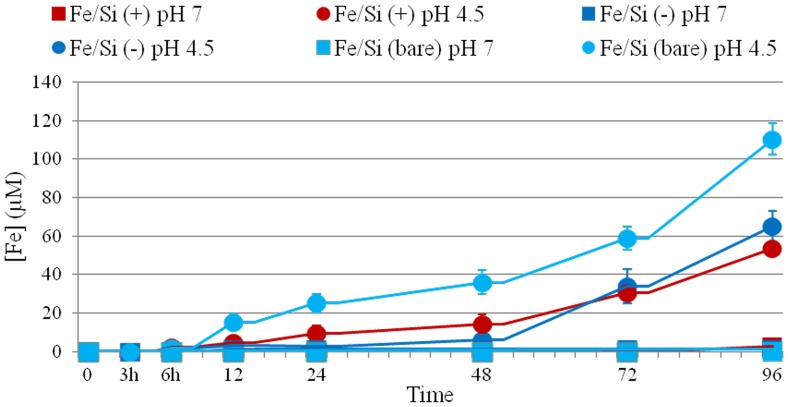
Effects of pH and surface functionalization on iron ions release from bare and passivated Fe3O4/SiO2 NPs.NPs degradation was evaluated both at pH 4.5 and pH 7 from 3 to 96 h. Neutral conditions were also probed in cell culture medium (DMEM, 10% FBS, pH 7.4), obtaining the same results (i.e., no detectable ion release).